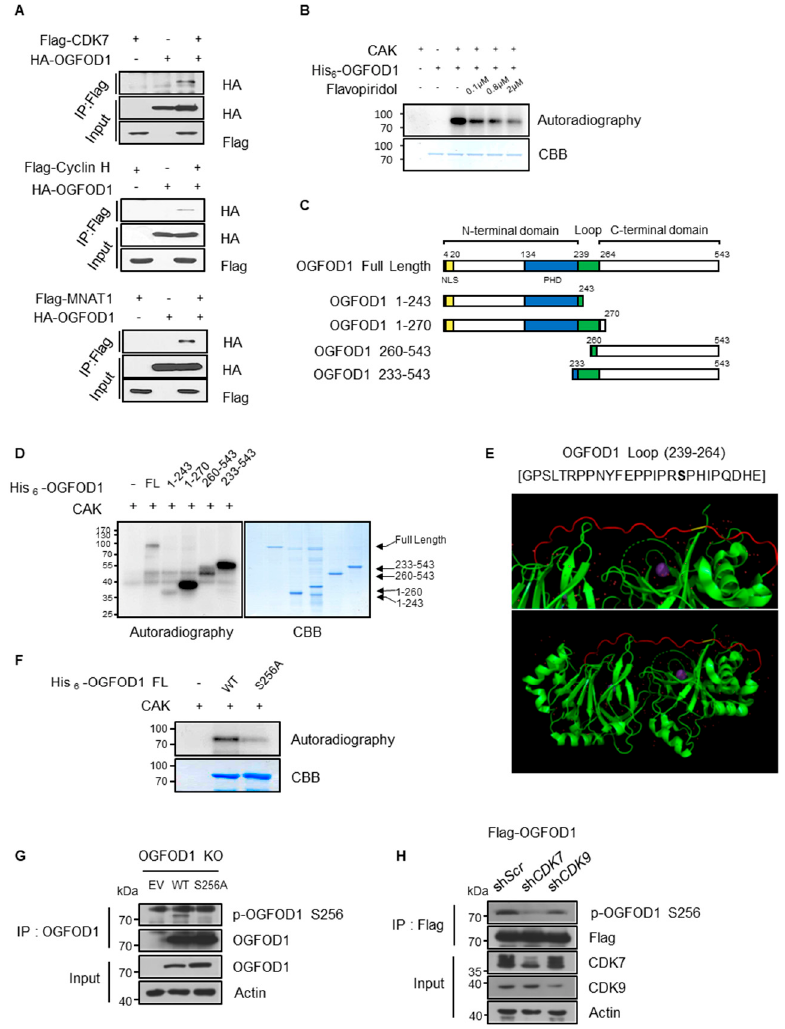
Figure 5. CDK7 and CDK9 phosphorylate serine 256 of OGFOD1 in vitro and in vivo. ( A ) Each of the CAK components (CDK7, cyclin H, and MNAT1) was co-expressed with HA-OGFOD1